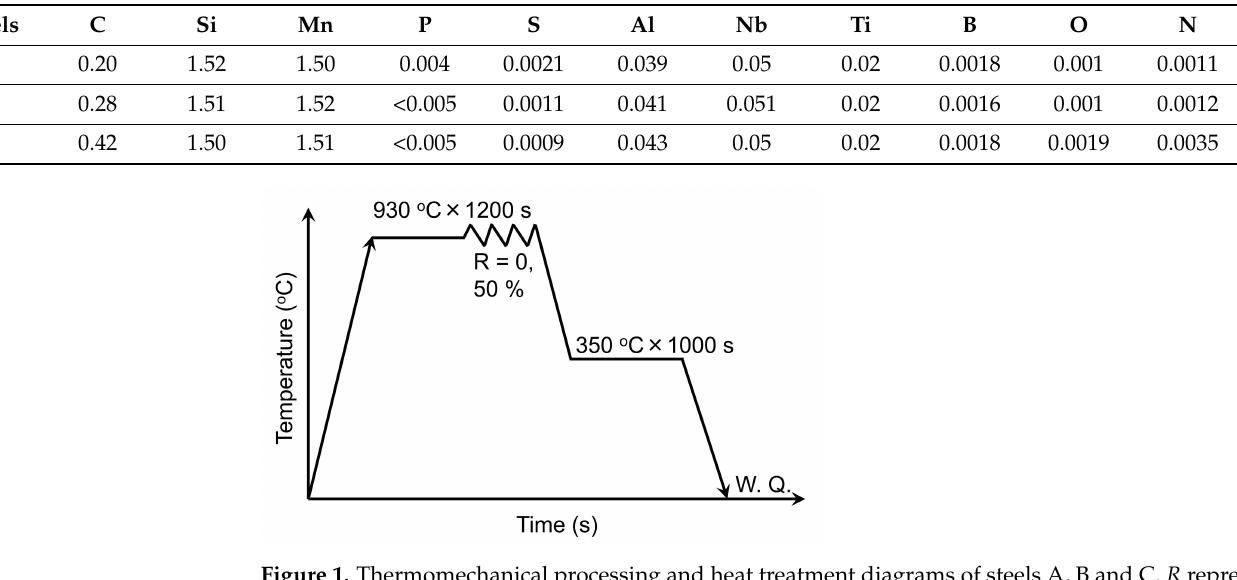
Figure 1. Thermomechanical processing and heat treatment diagrams of steels A, B and C. R repre- sents reduction ratio. W. Q. indicates water